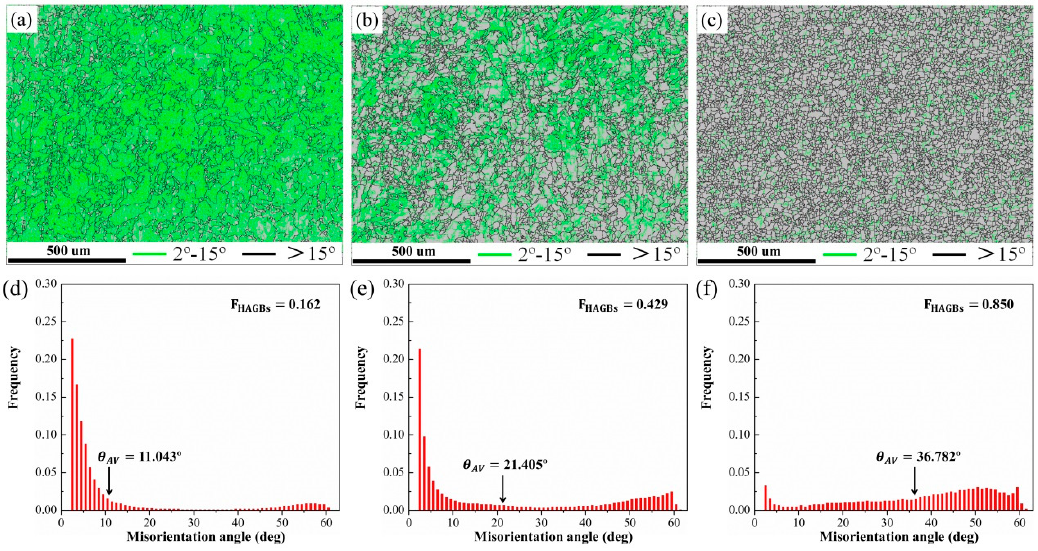
Figure 8. Grain boundary maps ( a – c ) and misorientation distribution maps ( d – f ) of the deformed specimen at various true strains: ( a , d ) ε = 0.105; ( b , e ) ε = 0.223; ( c , f ) ε = 0.916.